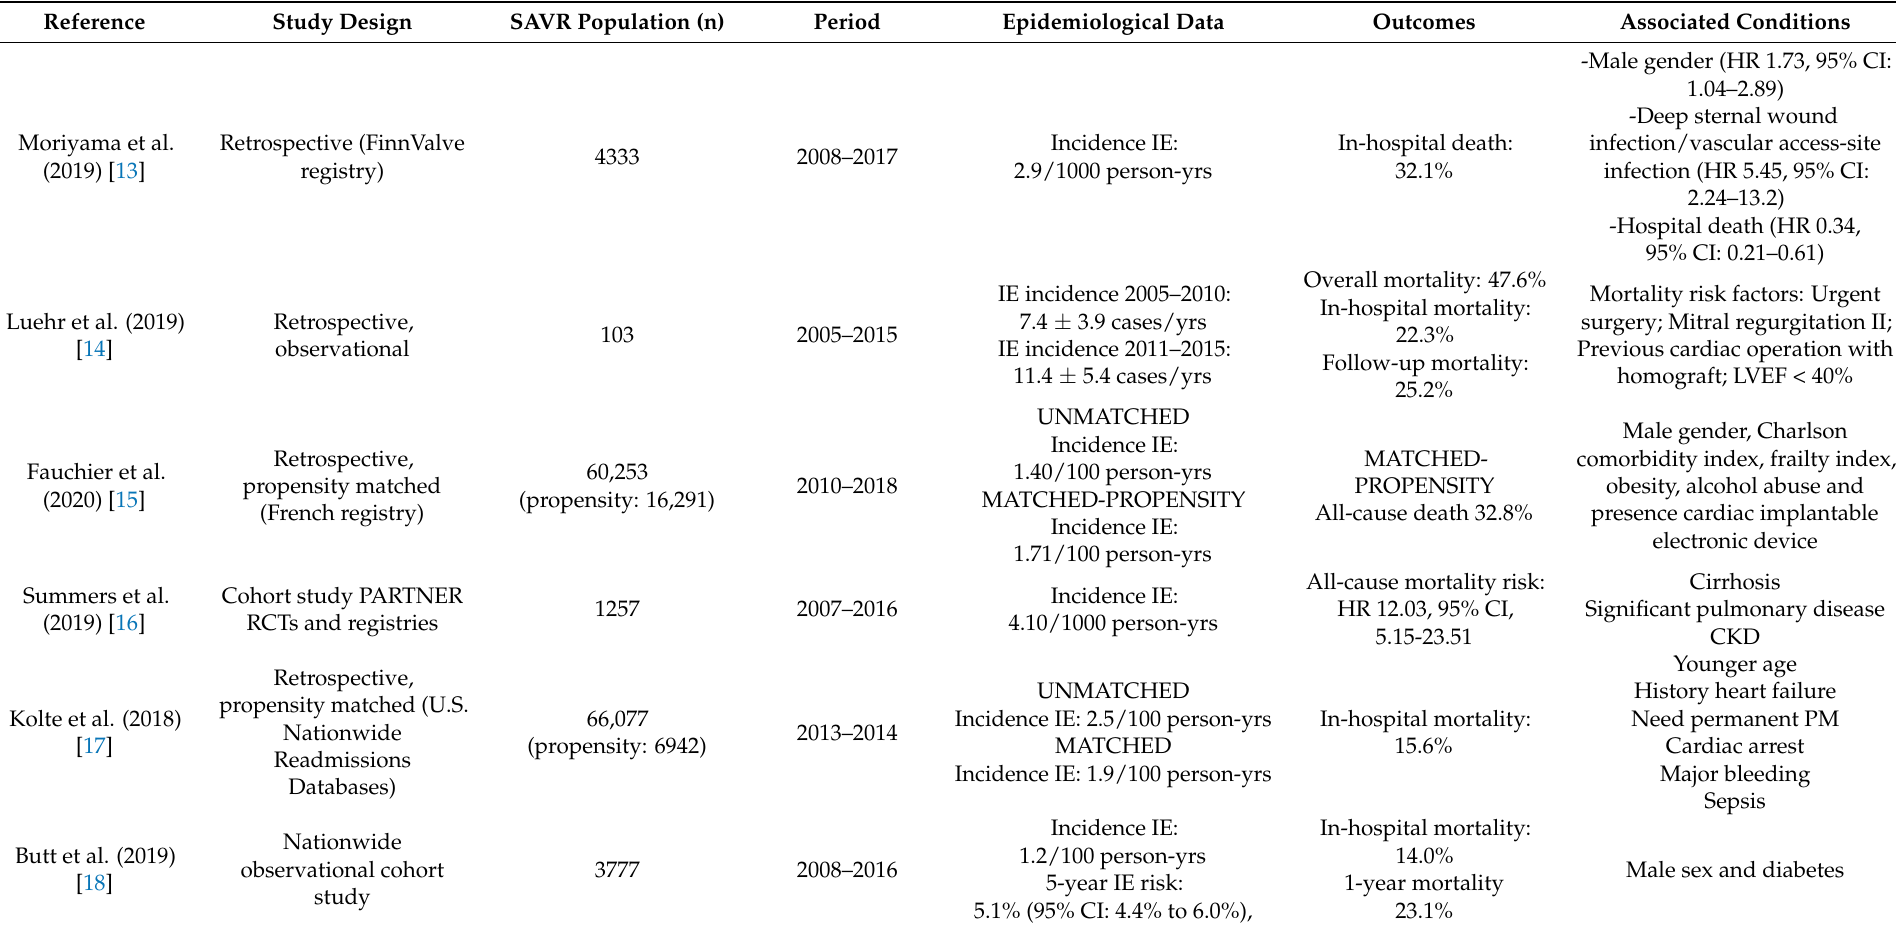
Table 1. Characteristics of the main studies dealing with infective endocarditis in surgical aortic valve replacement (SAVR). Study Design SAVR Population (n) Period Epidemiological Data Outcomes Associated